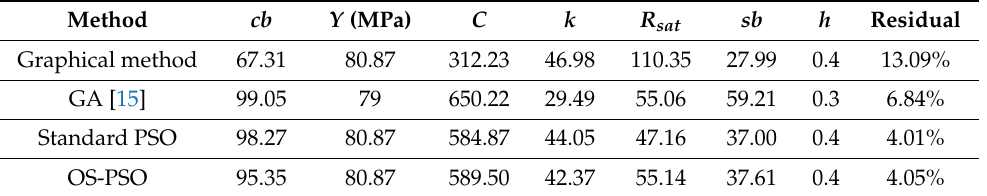
Table 2. Optimal parameters with standard PSO and OS-PSO.